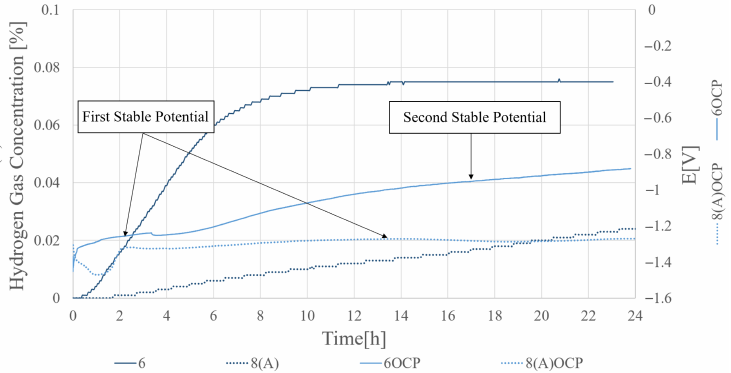
Figure 6. The hydrogen gas development and OCP measured in parallel during the cement hydration of samples 6 and 8(A). Two stable potentials were observed for the non-heat-treated sample 6, and the first stable potential for the heat-treated sample